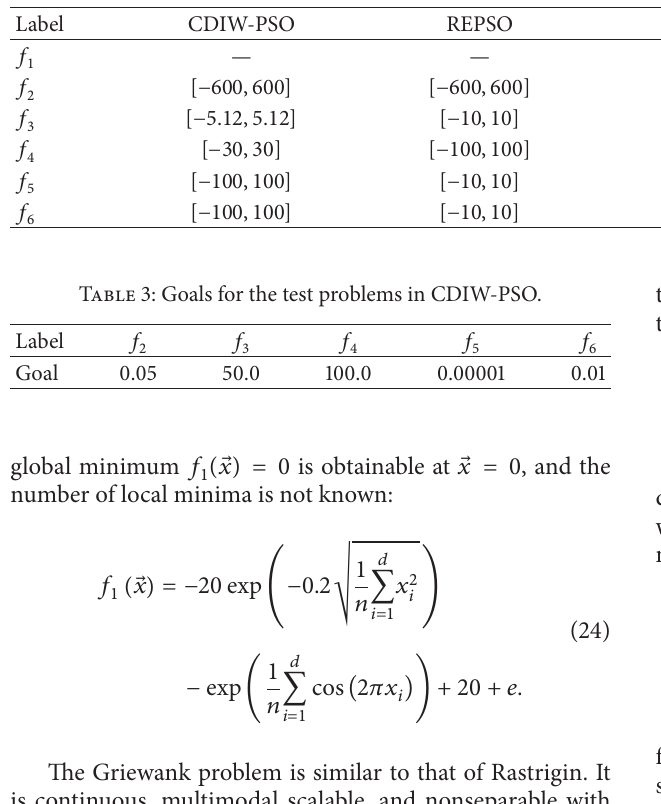
Table 2: Test problems search and initialization ranges for the PSO variants.